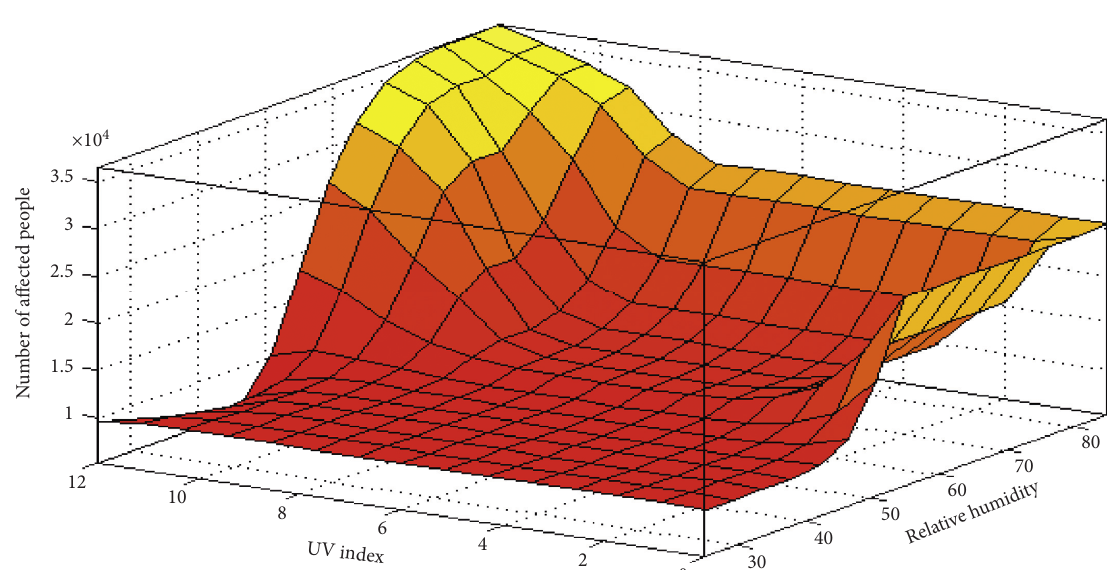
Figure 6: Relationship between UVI, RH, and the number of affected Figure 6. As the RH decreases, the number of affected people decreases, which is independent of the UVI.